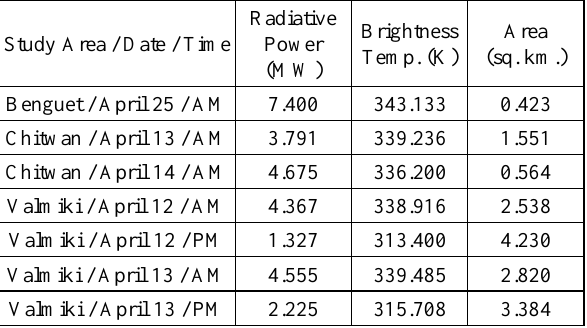
Table 4 . Comparison between radiative power, brightness temperature, and